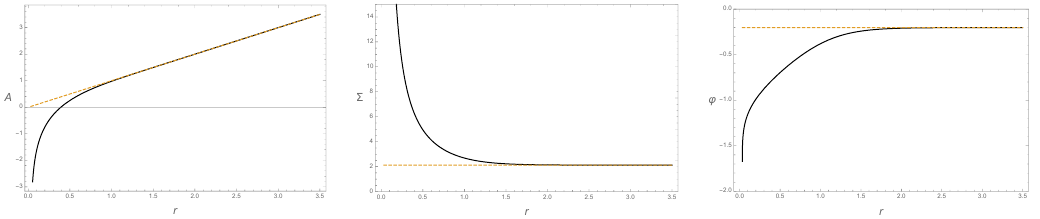
Figure 2 . The pro(cid:12)les of the bulk (cid:12)elds present in a supersymmetric (cid:13)ow from AdS 5 to the singular IR. The numerical solution is drawn in black, and the orange dashed lines give the asymptotic behavior of the (cid:12)elds at the AdS 5 critical point. The UV is approached as r ! 1